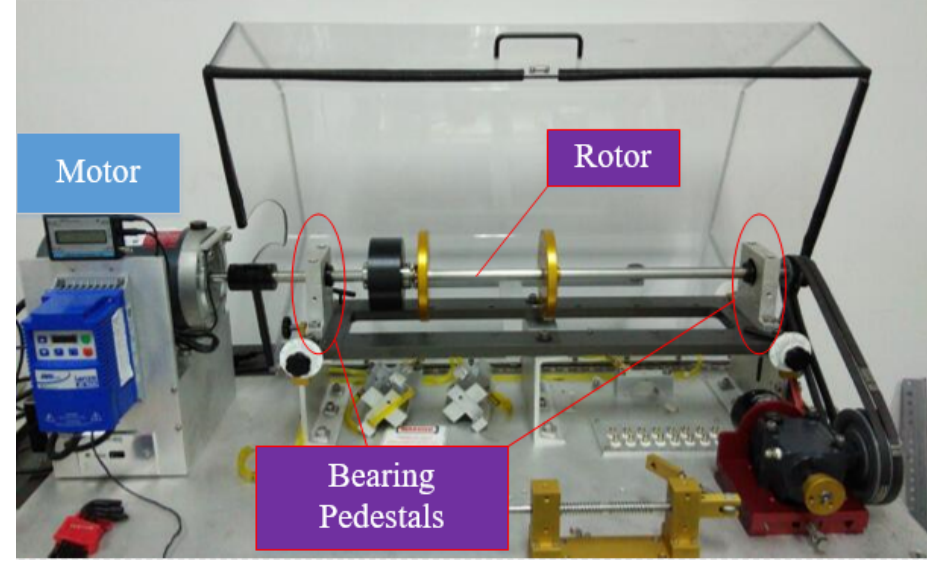
Figure 5. Comprehensive experimental platform for mechanical fault simulation.